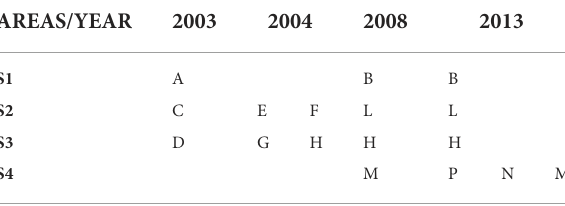
TABLE 1 Sediment cores for each sector. Letters for A to P represent the sampling stations (cfr. Figure 2). AREAS/YEAR